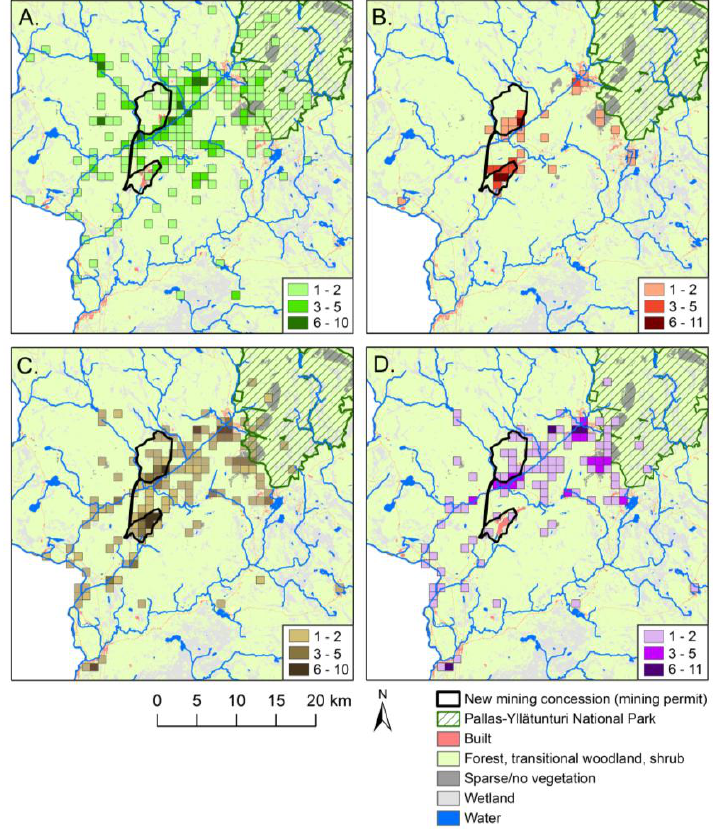
Figure 8. Numbers of map markings in 1 km grid squares for ( A ) pleasant places (positive experiences, n = 372), ( B ) unpleasant places (negative experiences, n = 93), ( C ) places where more knowledge on the state of the environment is needed (n = 100), and ( D ) places where positive or negative impacts of mine reopening would be experienced (n = 194). See Figure 2 for detailed landscape elements in the closed mining